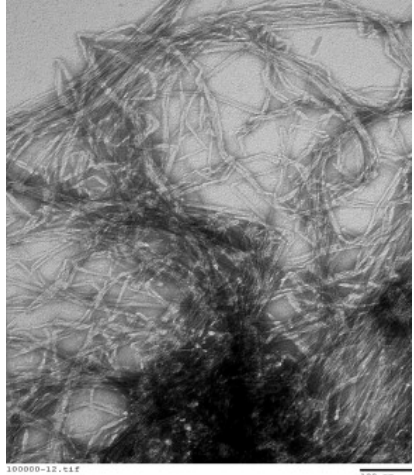
Figure 6. Image of a transmission electron microscope showing the morphology of cellulose nanofibers. Reproduced from Onuaguluchi et al. [85] with permission from Elsevier.